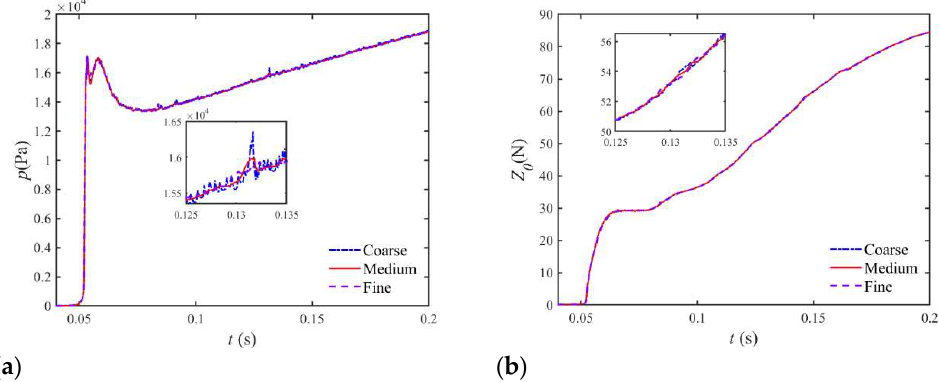
Figure 7. Convergent analysis of the time history curves of ( a ) pressure at the fore; ( b ) vertical force